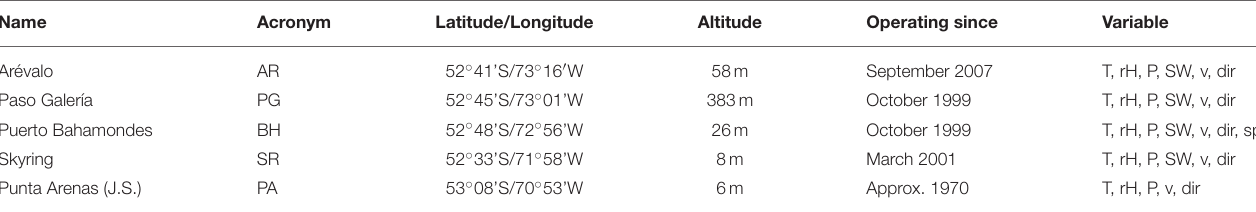
TABLE 1 | Pertinent data to the weather station and automatic weather stations used in this